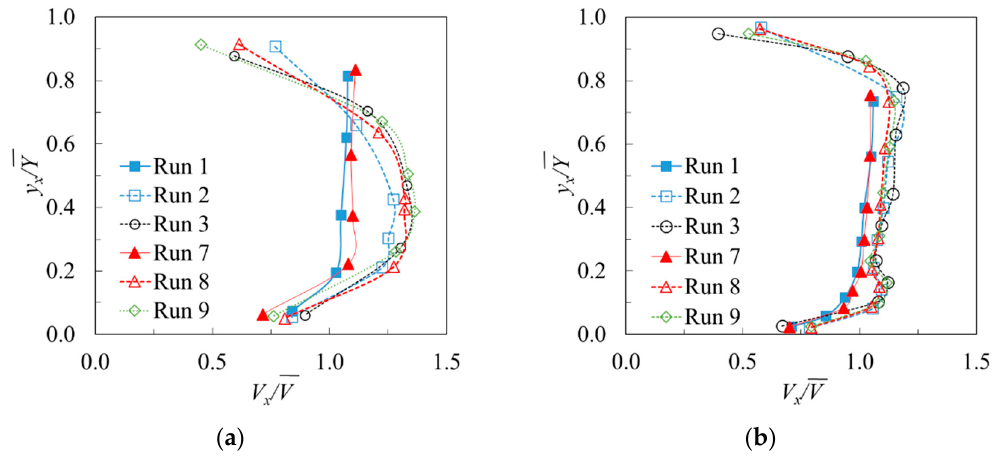
Figure 6. Vertical velocity profiles for ( a ) in the floodplain and ( b ) in the main channel